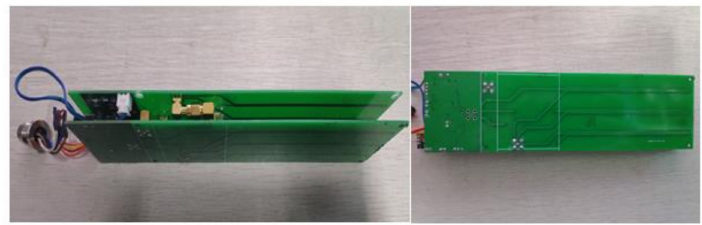
Figure 14. Photograph of the physical differential circuit board.